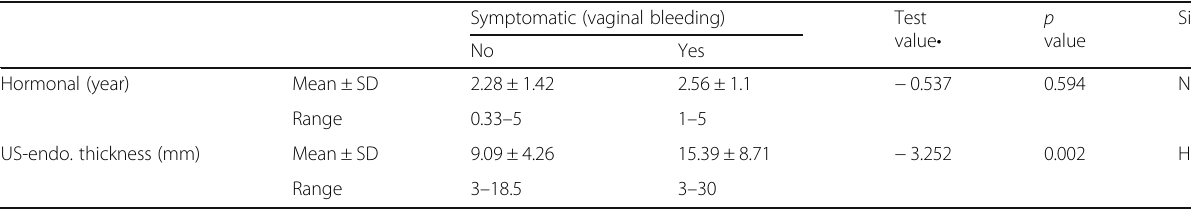
Table 4 Presence of symptoms with different variables